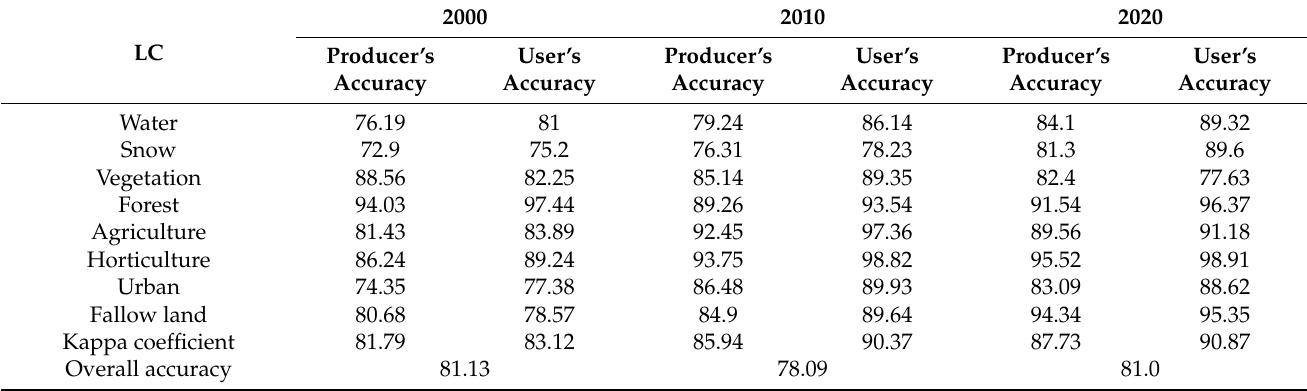
Figure 3. Classified land cover during 2000, 2010, and 2020 and projected LC of 2030. Table 3. Accuracy assessment reports of the image classification at the different temporal